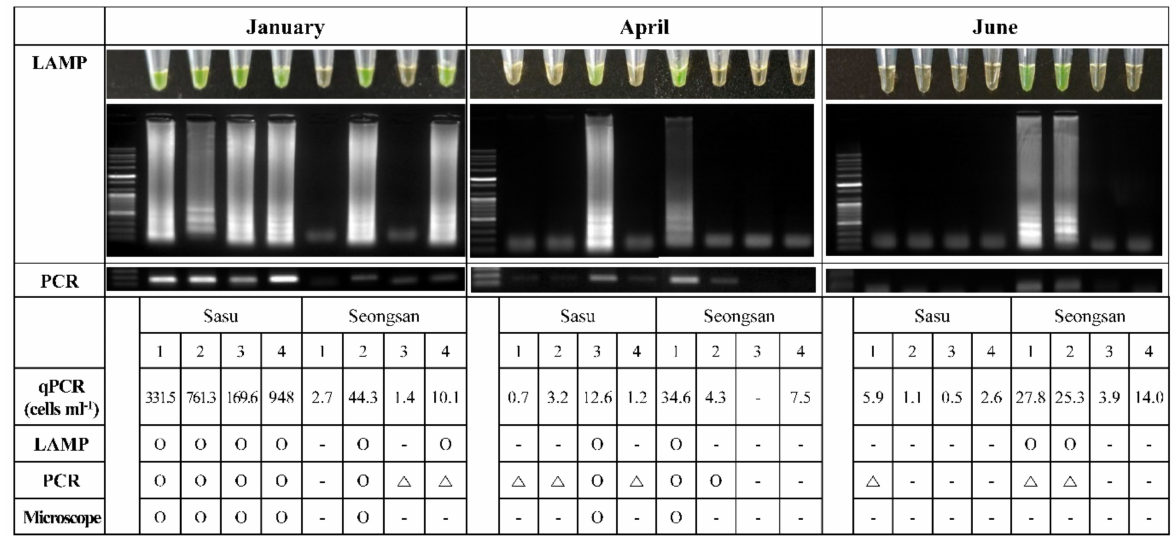
Figure 6. Field sample detection using loop-mediated isothermal amplification (LAMP) primers. Detection of each species was confirmed using a microscope, LAMP, PCR, and qPCR in seawater samples from Sasu and Seongsan of Jeju Island, 2019. The numbers (1 to 4) in the table indicate the randomly collected macrophytes